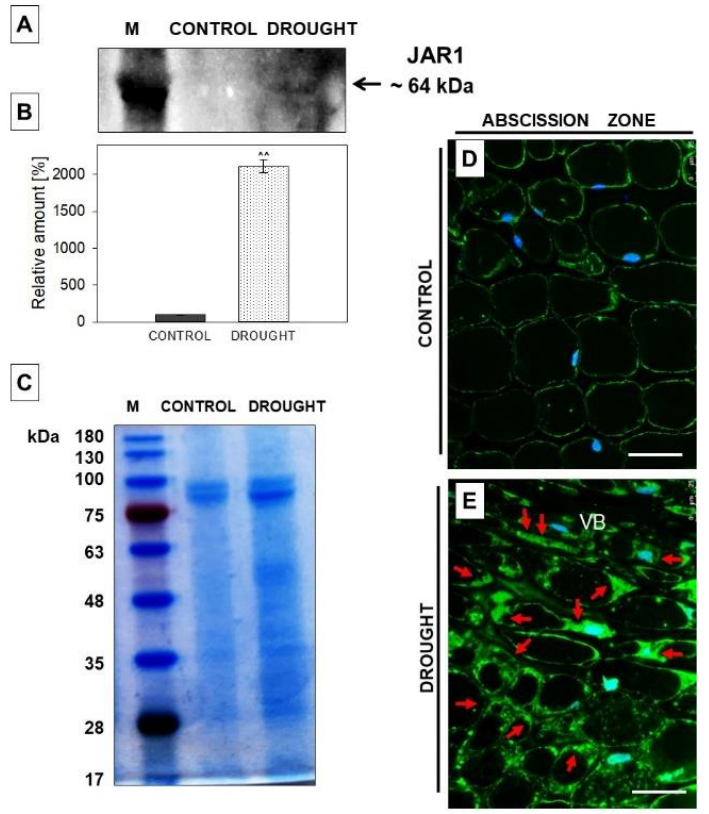
Figure 5. JASMONATE RESISTANT1 (JAR1) is induced in the abscission zone (AZ) cells of yellow lupine flowers in response to soil drought. AZ from flowers collected from 48 day-old plants growing under optimal soil moisture (70% water holding capacity, WHC) was a control, while the “drought” variant was AZ excised from 48 day-old plants subjected to drought (25% WHC), as written precisely in the Material and Methods section. Western blot analysis was performed with a JAR1 antibody and revealed the presence of a reactive band of ~64 kDa ( A ). The membrane was scanned, densitometry analysis was performed (100% was set for the control), and presented in ( B ). Protein samples separated by SDS-PAGE and stained with Coomassie Brilliant Blue ( C ). Protein marker (M) is displayed on the left and sizes in kDa are provided. Immunolocalization of JAR1 in flower AZ cells during soil water deficit ( E ) and under control conditions ( D ). Green fluorescence indicates JAR1 localization (marked by red arrows). Blue labeling corresponds to DAPI-stained nuclei. AZ region is restricted by white dotted lines. Abbreviation: VB—vascular bundle. Bars = 40 µ M. A significant difference is ˆˆ p < 0.01. Jasmonate signaling can be mediated by the COI1 protein. We investigated the possi- bility of the contribution of this enzyme to drought-related events taking place in flower AZ. Firstly we applied an anti-COI1 antibody for the protein measurement using Western blot. One isoform of ~70 kDa appeared both in the control and drought-treated tissue (Figure 6A), however, the band showed higher intensity in the stressed AZ (Figure 6B). Immunofluorescent analysis revealed that COI1 was detected in almost every cell of the AZ region (Figure 6E). The fluorescent labeling was observed mainly in the nuclei (Figure 6F) and cytoplasm surrounding the central vacuole, as small fluorescent spots (Figure 6E). AZ from plants growing in optimal moisture was labeled as being much weaker; the signal was visible in the peripheral cellular regions (Figure